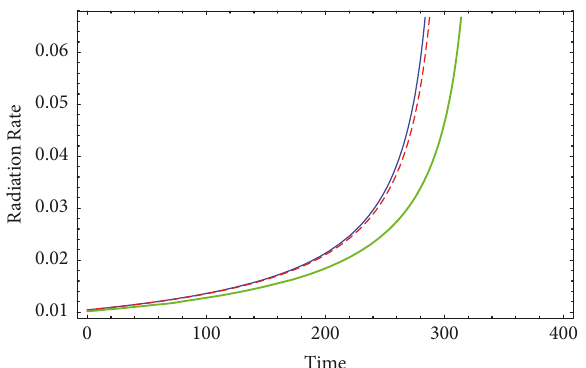
Figure 3: The radiation rate of the black hole versus time. The rate is in units of Planck mass per characteristic time and the time is in units of characteristic time. Here thin line (upper curve) represents GUP case (considering both 𝑎 2 and 𝑎 1 ), the dashed line (middle curve) represents GUP case (considering only 𝑎 1 ), and thick line (lower curve) represents the standard